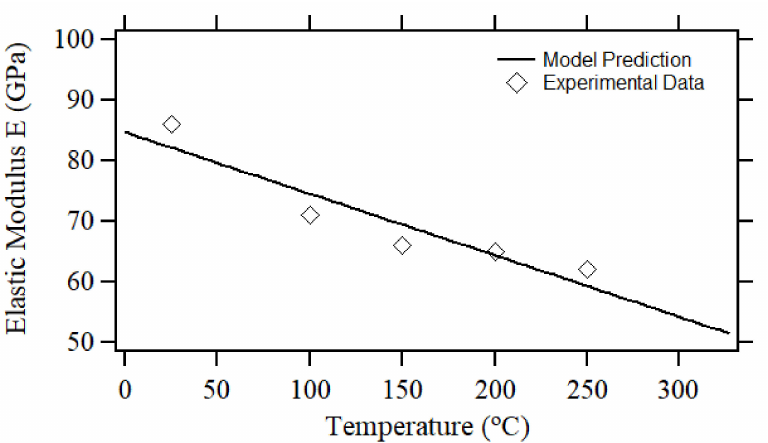
Figure 11. Elastic modulus versus temperature. Experimental data and model